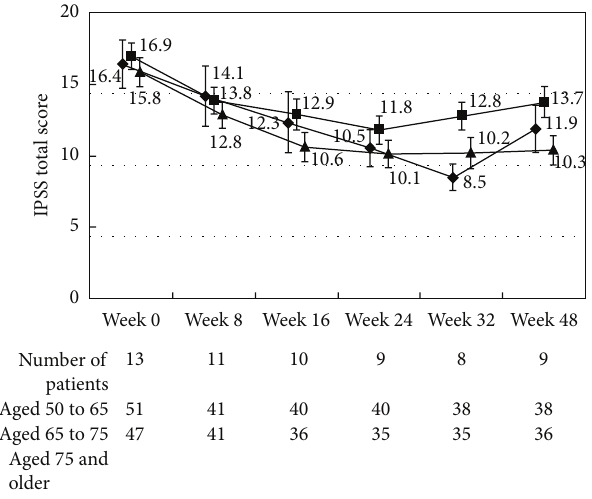
Figure 7: International Prostate Symptom Score total score by age. The scores in the patients aged from 50 to 65 ( ⧫ ), the patients aged from 65 to 75 ( ◼ ), and the patients aged 75 and older ( 󳵳 ) are shown. The values are LS mean ± SE. 𝑃 = 0.2055 (repeated ANOVA).